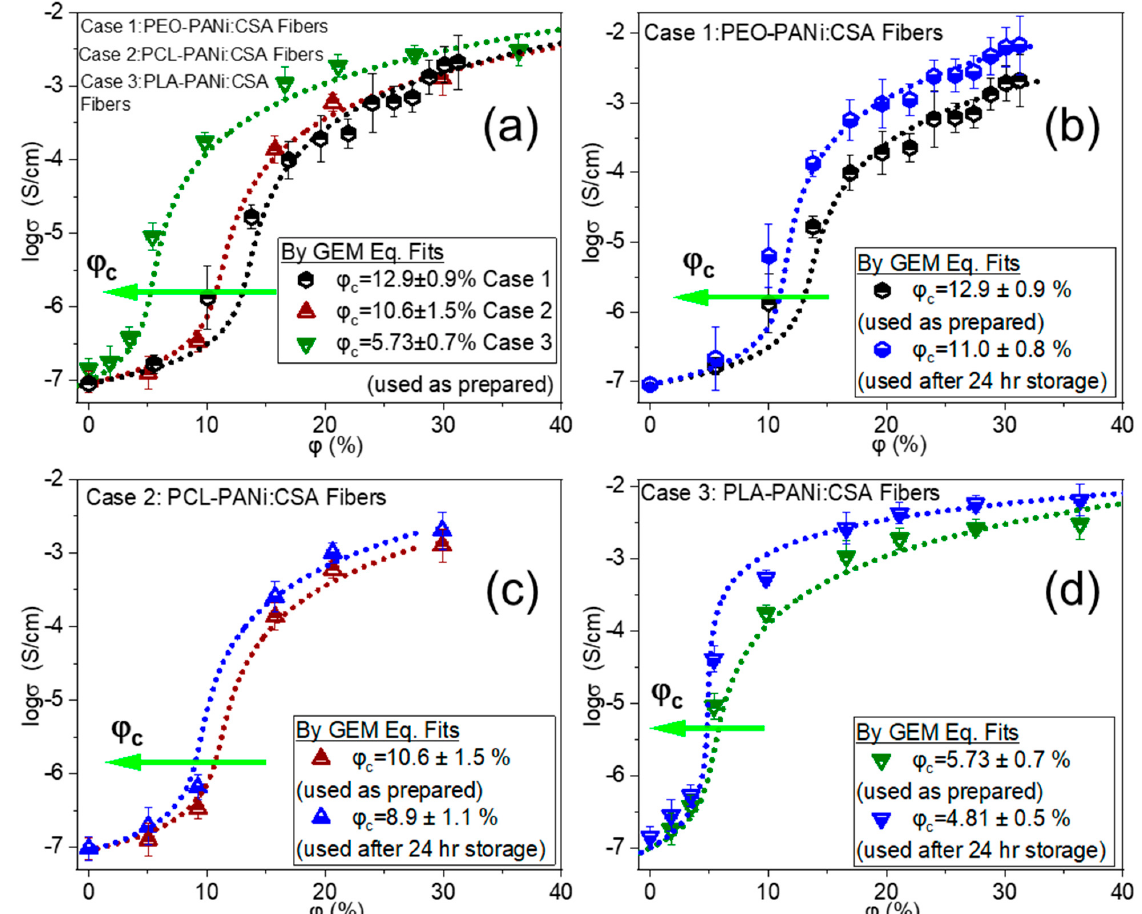
Figure 4. Logarithm of conductivity ( log σ ) against percentage volume fraction ( φ % ) of PANi for PEO(900kD)-PANi:CSA fibers (Case 1), PCL-PANi:CSA fibers (Case 2), and PLA-PANi:CSA fibers (Case 3), respectively. Panel ( a ) shows the comparison between all three cases (Case 1–Case 3). Panels ( b – d ) show the storage-time dependence for Case 1, Case 2, and Case 3, respectively. The samples are stored at room temperature for 24 h. The dotted lines show the closest fits to the GEM model (Equation (2)).